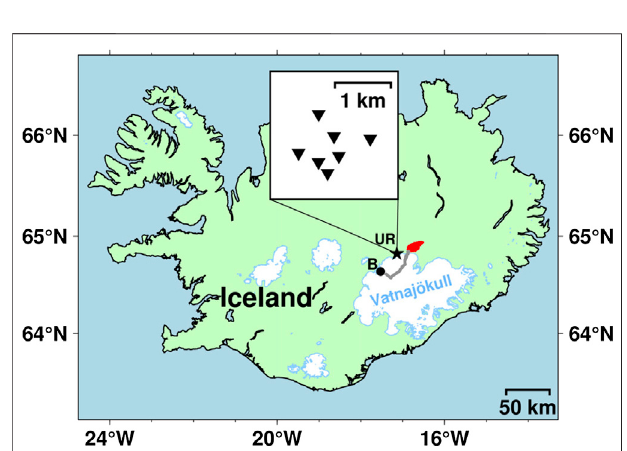
FIGURE 6 | Map showing location and geometry of the seven station UR seismic array deployed as part of FUTUREVOLC to collect data during the 2014 – 2015 eruption at Bárðarbunga volcano in Iceland. The location of the erupted lava fl ow fi eld in Holuhraun is indicated in red, Bárðarbunga volcano by the black letter B and the approximate propagation path of the dyke intrusion below the glacier by the gray line.